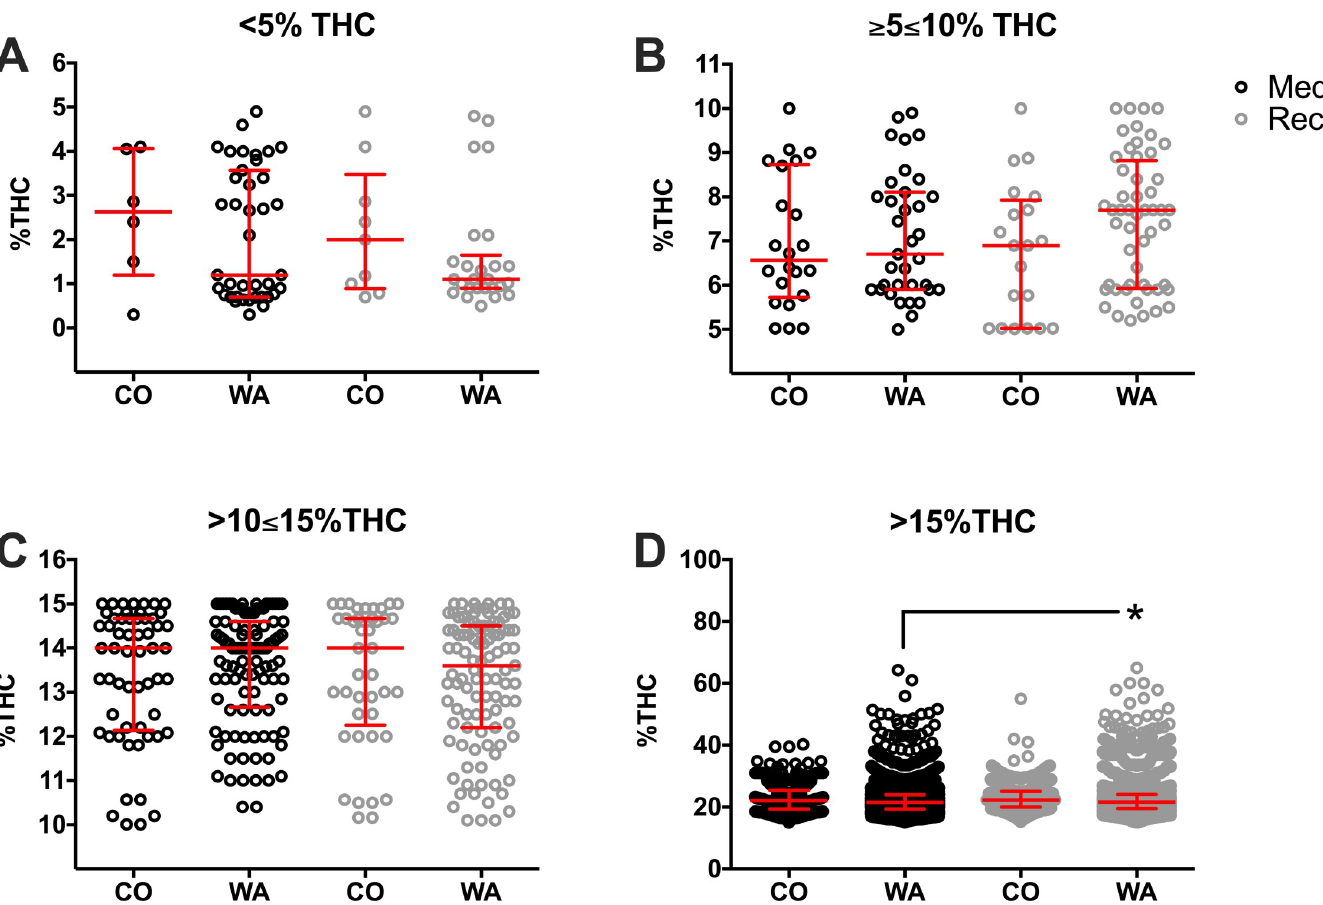
Fig 8. Percent THC at different strength product categories based on THC content in CO and WA medicinal and recreational programs. Products are presented in the following categories: < 5% THC (A), � 5 � 10% THC (B), > 10 � 15% THC (C), and > 15% THC (D) in CO recreational or medicinal menus and WA recreational or medicinal dispensaries. Every herb cannabis product in the surveyed states and programs are plotted as open circles. Medicinal programs (Med; black circles) and recreational programs (Rec; grey circles) were compared. Data are presented as median with interquartile range. � P < 0.05 Recreational WA vs. Medicinal WA (linked line). One-way ANOVA and Tukey’s multiple comparison test. Descriptive statistics could be found in S10 Table. The outlier products in the graph might represent herbal products infused with concentrated THC or CBD extracts, however we did not observe such a claim in the studied websites where these products were offered.